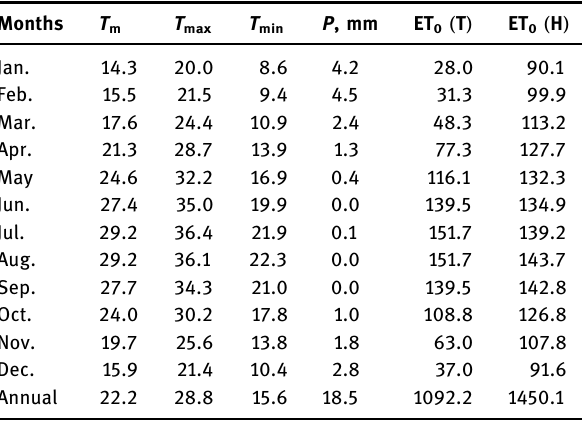
Table 1: Climatic parameters of the year 2017 represented El - Nubaria climate station. T m , mean temperature ( °C ) ; T max , highest temperature ( °C ) ; T min , lowest temperature ( °C ) ; P , precipitation ( mm )